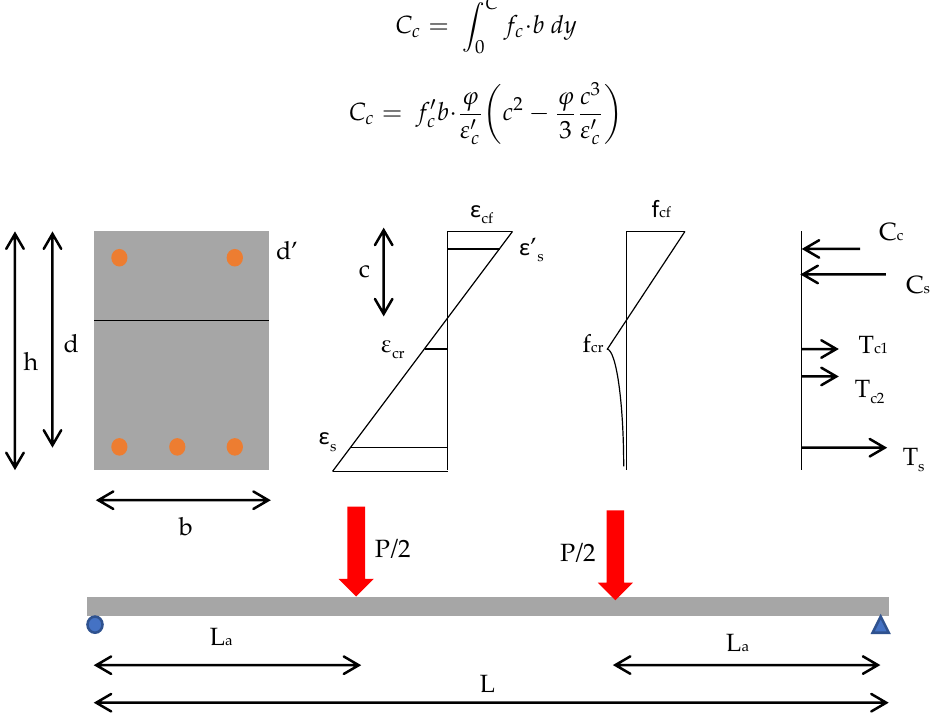
Figure 5. Beam and cross section geometrical and material